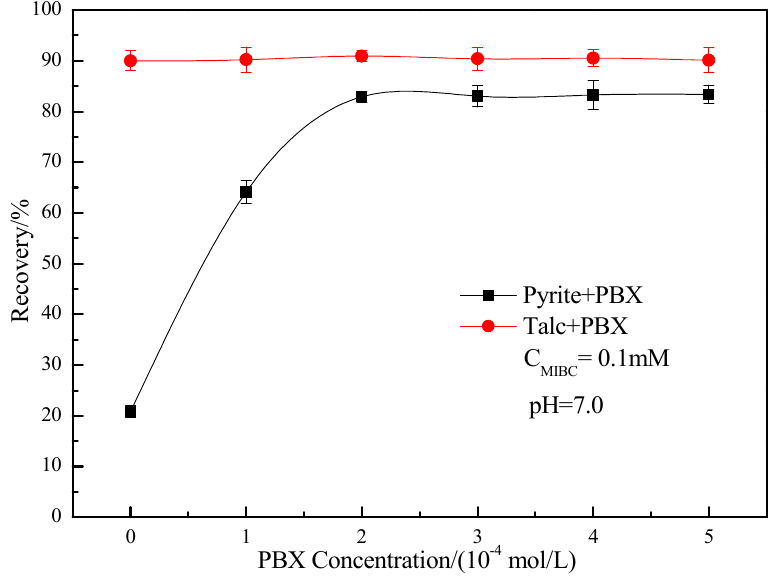
Figure 4. Effect of PBX concentration on the microflotation recovery of pyrite and talc.